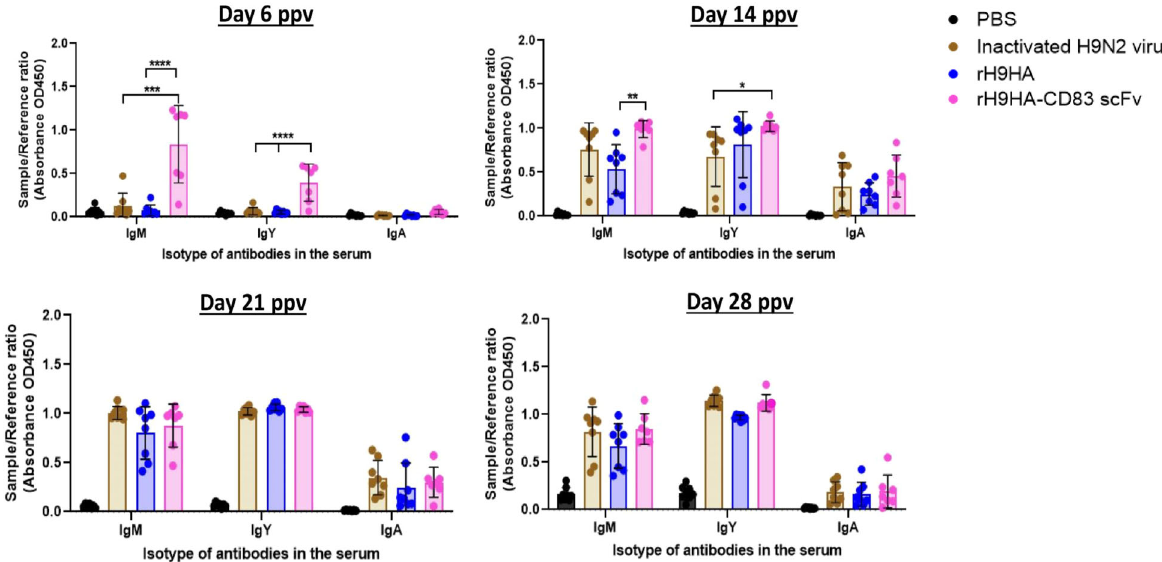
Fig. 6 HA-speci fi c IgM, IgY, and IgA antibody levels in the serum of chickens immunised with 35 μ g dose of rH9HA, rH9HA-CD83 scFv, and inactivated H9N2 virus vaccines. The HA-speci fi c isotypes of the antibodies were determined in 200-fold diluted sera collected at day 6, 14, 21, and 28 post primary vaccination by ELISA. The plates were coated with 1 μ g of recombinant H9HA protein overnight at 4 °C. For detection, the plates were incubated with respective sera for 1 h at room temperature. This was followed by further incubation for 1 h with 1:3000 diluted anti-chicken IgM, IgY, and IgA antibodies. The colorimetric detection was carried out by adding tetramethylbenzidine (TMB) substrate and absorbance at 450 nm was recorded. The amount of HA-speci fi c IgM, IgY, and IgA antibodies were expressed as a sample to reference ratio (relation of absorbance of a tested serum sample to the absorbance of the reference serum). Data are presented as mean ± SD and analysed by one-way ANOVA followed by Tukey ’ s multiple comparison test. **** p < 0.0001 *** p < 0.001 ** p < 0.01 * p < 0.05. ppv post primary vaccination.